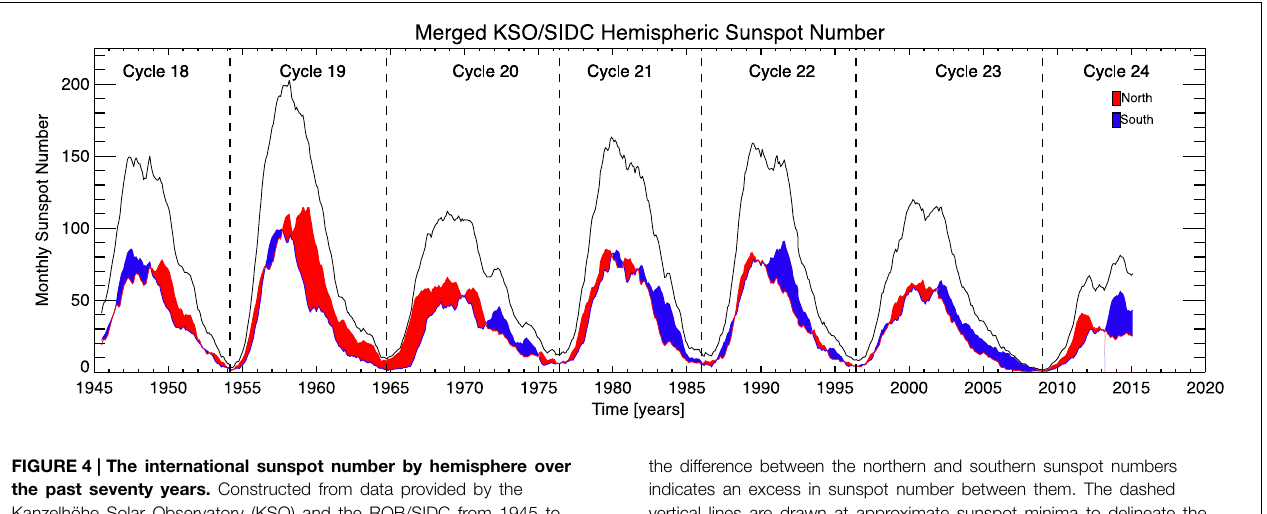
FIGURE 4 | The international sunspot number by hemisphere over the past seventy years. Constructed from data provided by the Kanzelhöhe Solar Observatory (KSO) and the ROB/SIDC from 1945 to the present. The northern (red) and southern (blue) hemispheric sunspot numbers are shown against the total of the two (black). The shading of